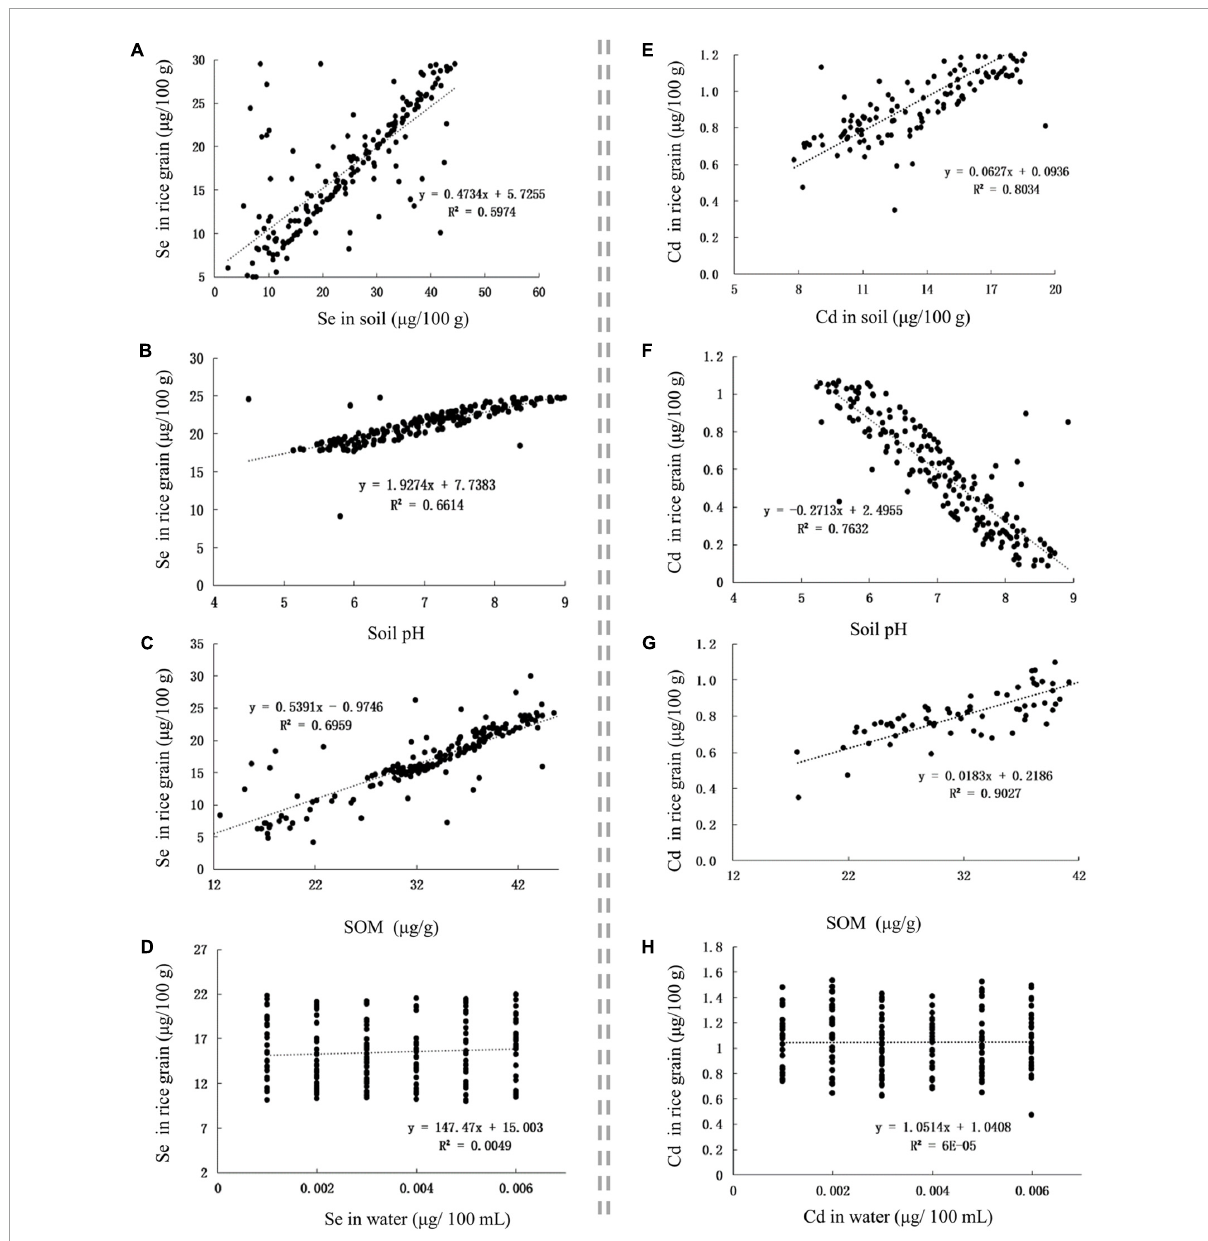
FIGURE3 The influence of factors on Se and Cd contents in rice grain. (A–D) The influence of Se content in soil, soil pH, SOM, and Se content in water on Se content in rice grain, respectively. (E–H) The influence of Cd content in soil, soil pH, SOM, and Cd content in water on Cd content in rice grain,